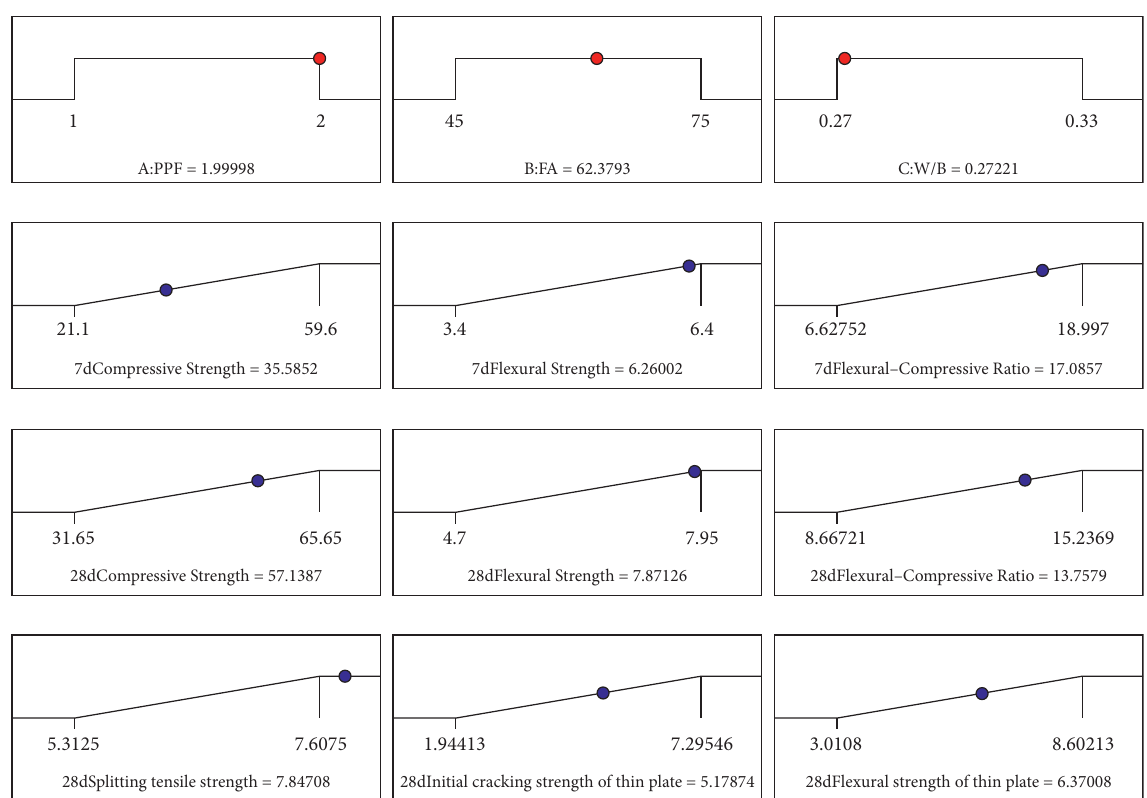
Figure 17: Change of expected value function based on multiobjective